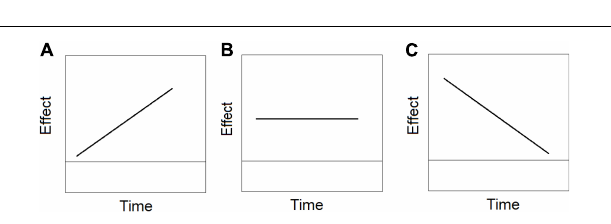
FIGURE 4 | Examples of (A) positive slope delta plot in which the effect increases with time, (B) zero slope delta plot in which the effect has the same magnitude across time, and (C) negative slope delta plot, in which the effect decreases with